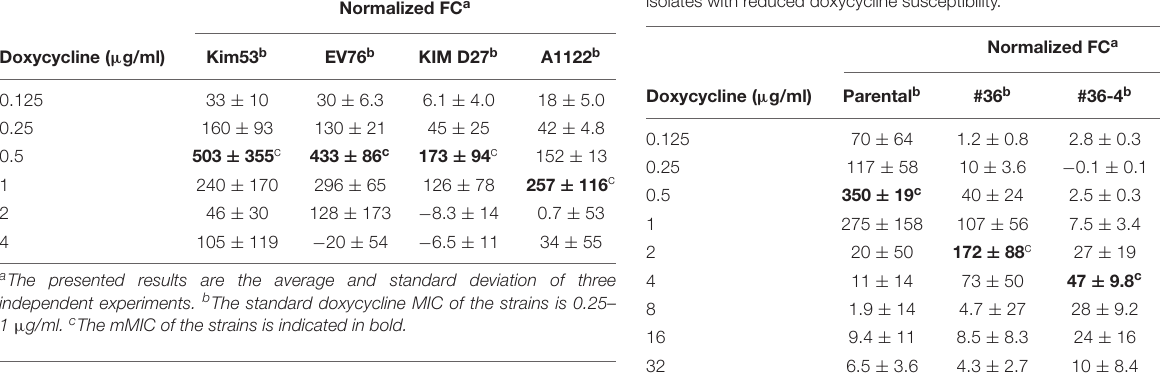
TABLE 4 | Standard MIC values of the avirulent Y. pestis Kim53pCD1 − pPCP1 − isolates with reduced doxycycline susceptibility.